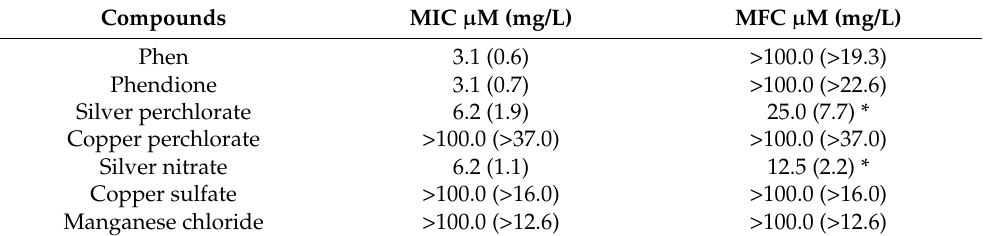
Table 3. Effect of phen, phendione and different metal salts on the conidia F. pedrosoi